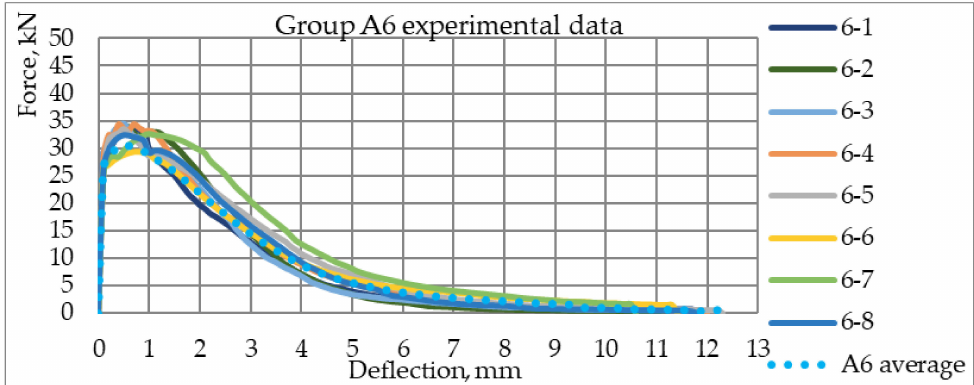
Figure 20. Load—sample center vertical deflection graphs for the specimens in Group A6.